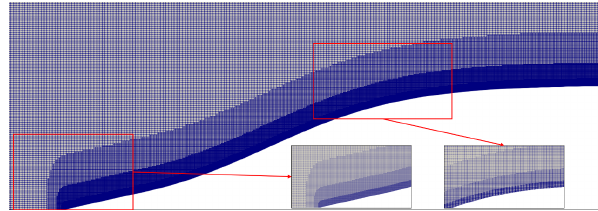
Figure 19. Schematic of the local refinement of the grid.